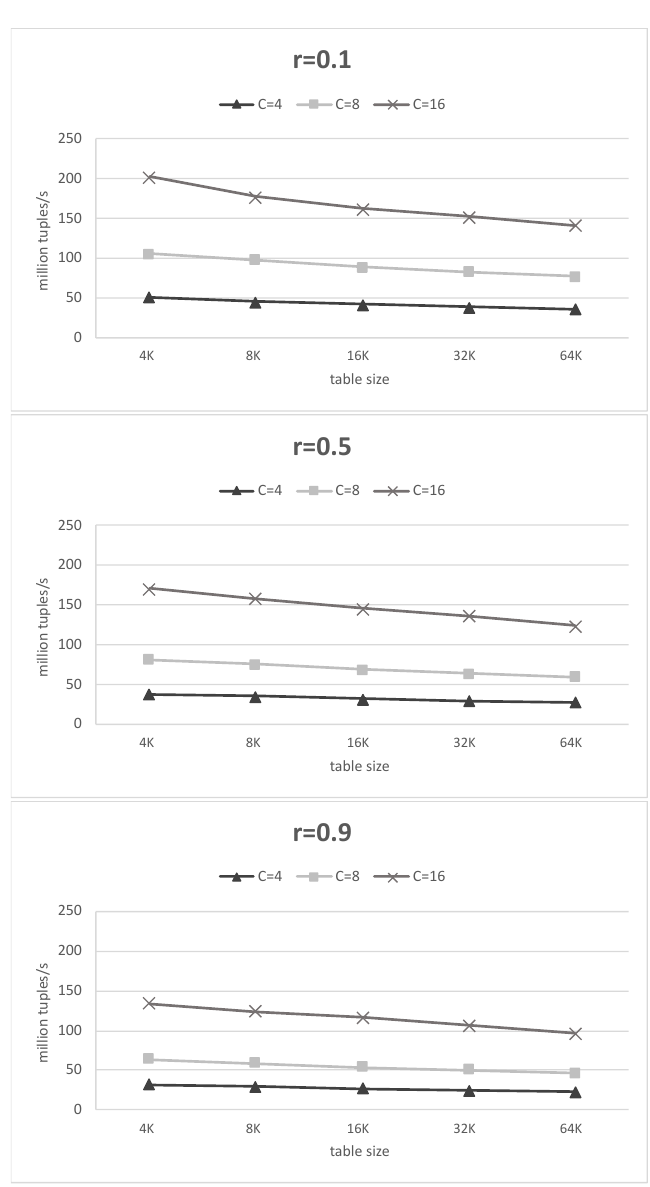
Figure 7. Throughput results under different